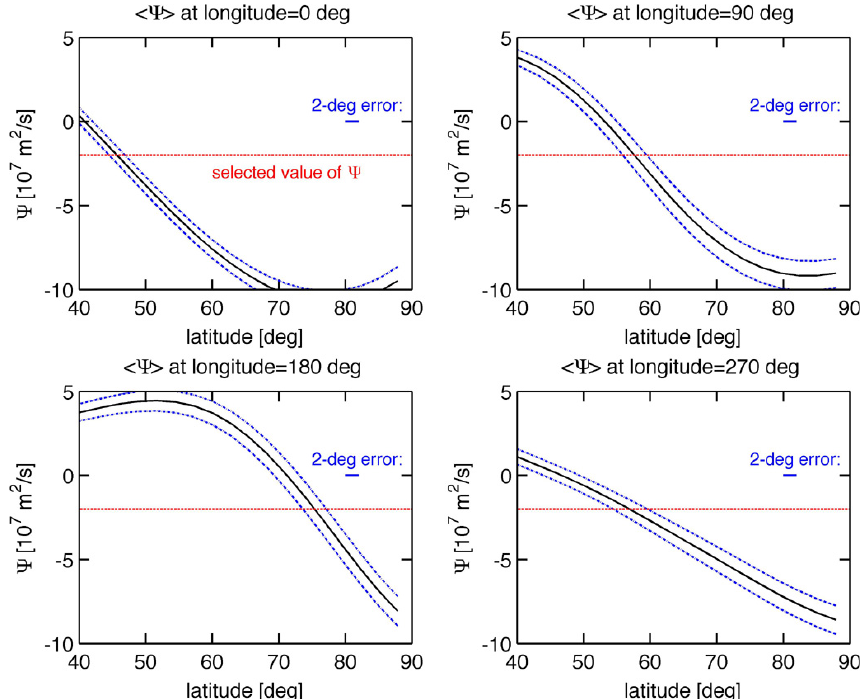
Fig. A1. Estimation of the error of the latitude position of a selected streamline (case of the red streamline in Fig. 6 ). The black lines show the latitudinal dependences of < 9 > at the longitudes 0, 90, 180, and 270 ◦ E for phase 0 of the 20-day oscillation (composite for minimal ozone at Bern). The error of the mean σ m is depicted by the blue-dashed lines. The scales are the same for all viewgraphs. The blue error bar indicates a 2 ◦ interval (just for orientation). The selected value of the streamline is 9 = − 2 × 10 7 m 2 s − 1 , and this value is marked by the red